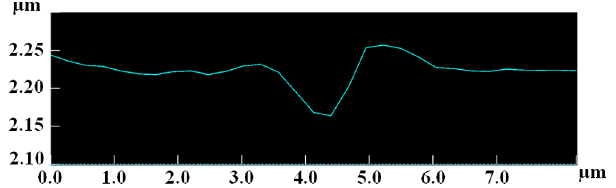
FIG. 4. Surface profile across the AB line from Fig. 3.